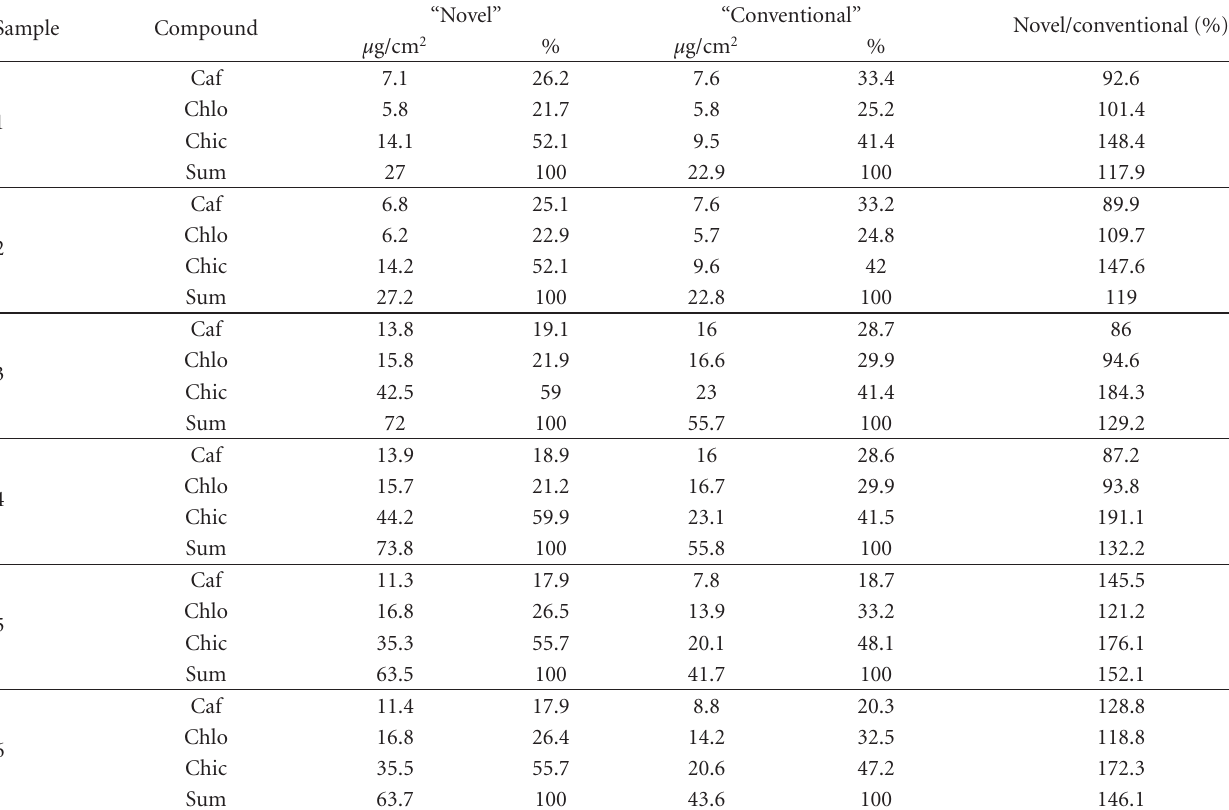
Table 1: Levels of caftaric, chlorogenic and chicoric acids in extracts obtained by the “novel” method and a “conventional” method. Similar amounts of tissue sampled from 2 comparable leaves from 3 di ff erent chicory plants were extracted by the two methods, and quantities of the hydroxycinnamate compounds in the extracts were determined by HPLC (see text for details). Content are expressed in µ g/cm 2 of fresh leaf tissue